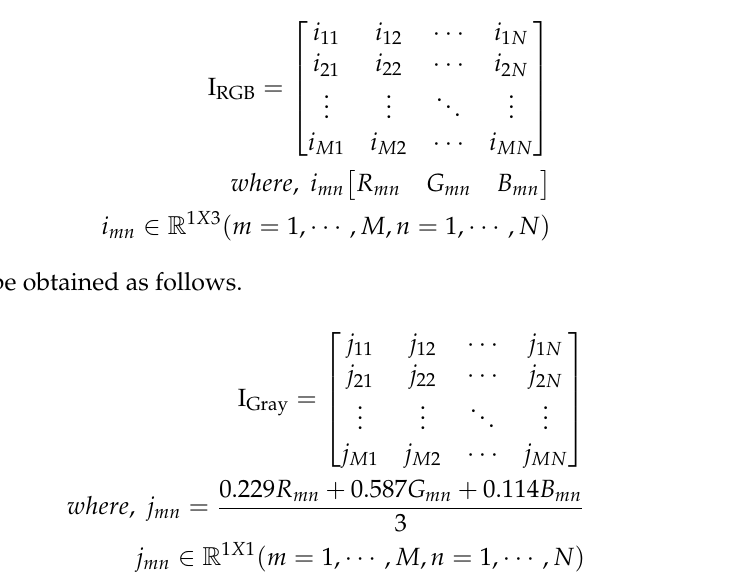
Figure 1. Stain defect classification system. Let R mn , G mn , and B mn are red channel, green channel, and blue channel of the image, respectively, while M and N are the height and width of the image,